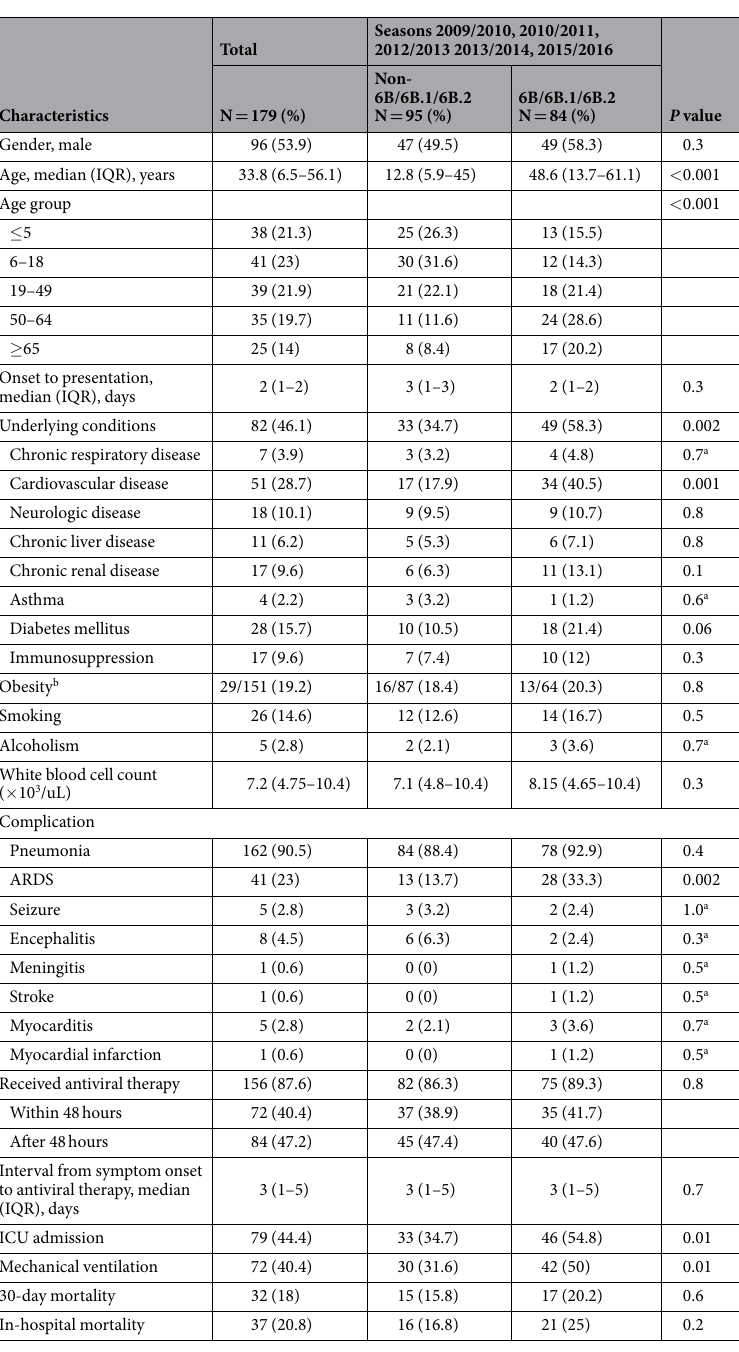
Table 3. Demographic and Clinical Characteristics of Patients with Influenza A(H1N1)pdm09-associated complication in the clade 6B/6B.1/6B.2-predominant seasons and non-clade